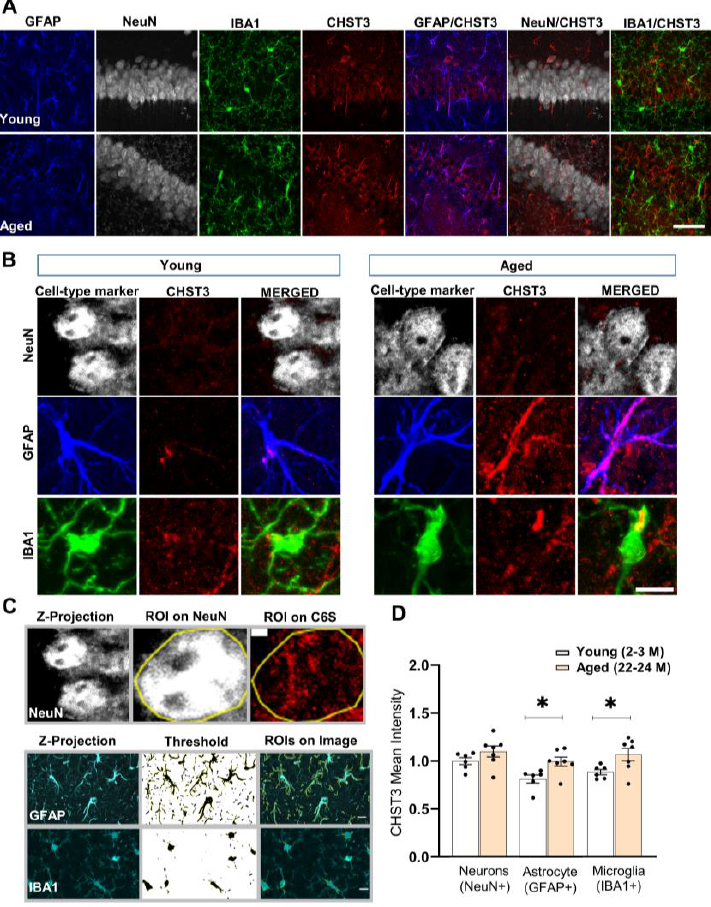
Figure 6. Cell-specific increase in CHST3 protein levels in the hippocampus of 22-24 M-old mice. ( A ) CHST3 protein levels were quantified in neurons, astrocytes, and microglia, which were identified using NeuN, GFAP, and IBA1 antibodies, respectively, in the hippocampus of 2-3 M-old mice and 22-24 M-old mice (scale bar, 50 µm). ( B ) Zoomed confocal images of CHST3 staining (scale bar, 10 µm). ( C ) Method of cell selecting. ( D ) The mean intensity of CHST3 was increased in astrocytes and microglia but not in neurons of 22-24 M-old mice compared to 2-3 M-old mice. Bar graph shows mean ± SEM values; * p < 0.05 represent significant difference between 2-3 M-old mice ( n = 6) and 22-24 M-old mice ( n = 7).